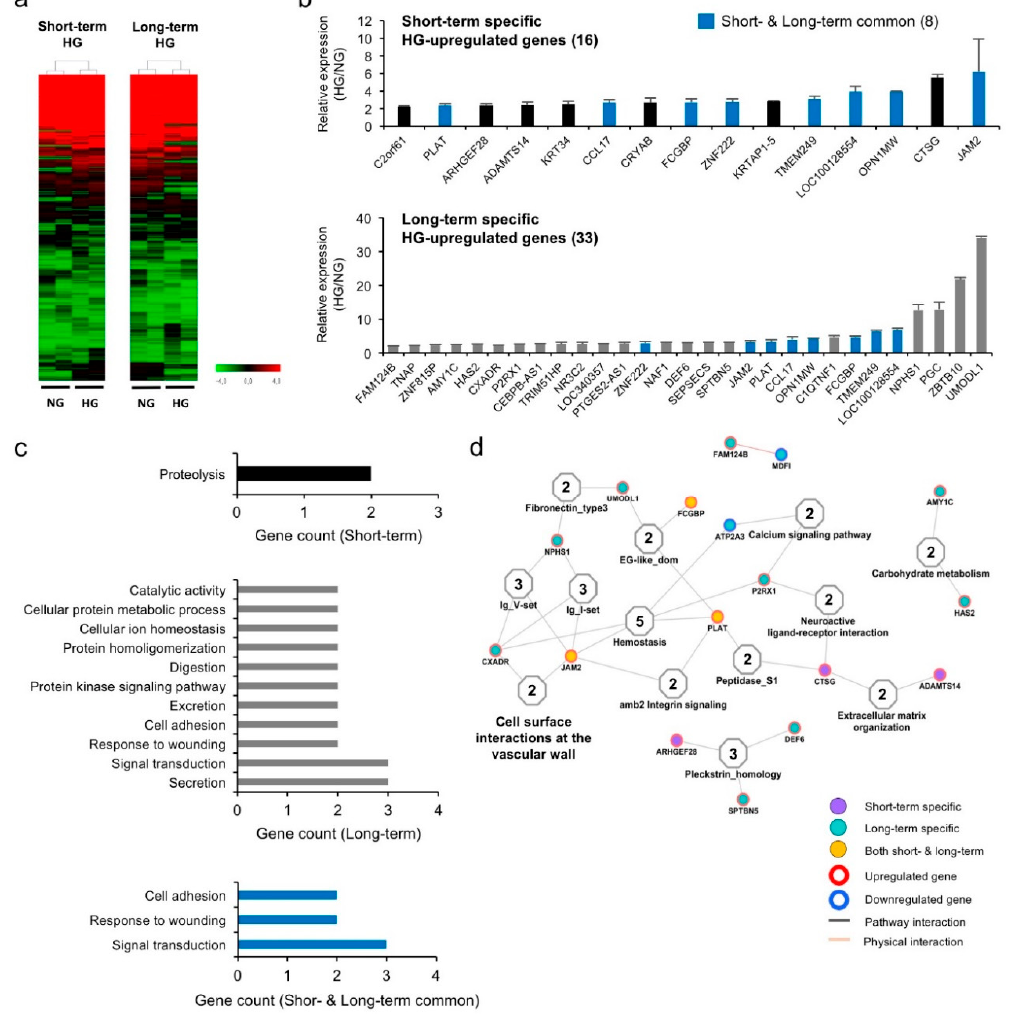
Figure 2. Short-term and long-term effects of HG treatment on gene expression in hPVCs. ( a ) Heatmap of gene expression and unsupervised hierarchical cluster analysis. hPVCs were cultured under NG